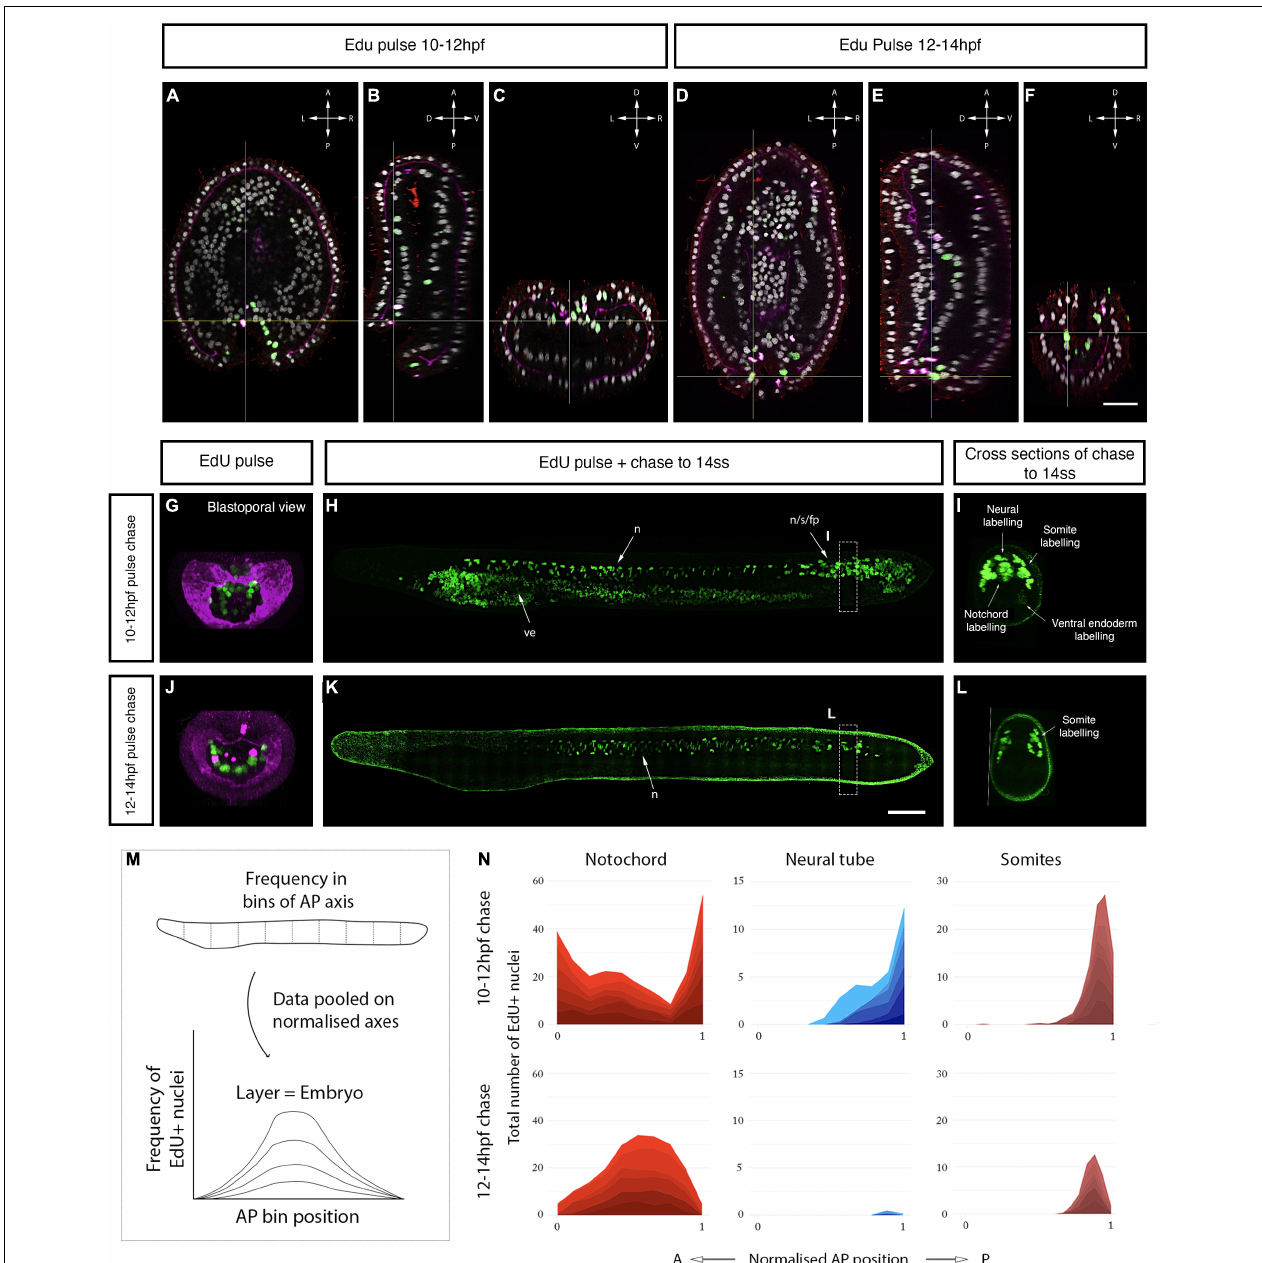
FIGURE 6 | Axial progenitor fates are spatially regionalised across the late blastopore lip. (A–C) Distribution of EdU- and PhH3-positive nuclei after an EdU pulse between 10 and 12 hpf, shown in orthogonal coronal (A) , sagittal (B) , and transverse sections (C) intersecting at the level of the blastopore (as indicated by the yellow lines). Scale bars are 30 µ m. (D–F) Distribution of EdU-positive nuclei after an EdU pulse between 12 and 14 hpf, shown in a coronal (D) , sagittal (E) , and transverse sections (F) intersecting at the level of the blastopore (as indicated by the yellow lines). Compass shows orientation of each plane in panels (A–F) . (G) Maximum projection through the blastopore in an embryo pulsed with EdU between 10 and 12 hpf, as shown in panel (C) , marking proliferative cells in the dorsal and upper-lateral lips. (H) Maximum projection through the sagittal midline of an embryo EdU pulsed at 10–12 hpf, as shown in panel (G) , showing contribution of EdU-positive cells in the dorsal blastopore lip to neural tube, notochord and somites. (I) Transverse section through posterior body of embryo shown in panel (H) , showing tissue-specificity of EdU-positive cells. (J) Maximum projection through the blastopore in an embryo pulsed with EdU 12–14 hpf, as shown in panel (F) , showing proliferating cells in the ventral and lower-lateral lips. (K) Maximum projection through the sagittal midline of an embryo EdU pulsed at 12–14 hpf, as shown in panel (J) , revealing the contribution of proliferating cells to the posterior somites. (L) Transverse section through posterior body of embryo shown in panel (K) , showing tissue-specificity of EdU-positive cells. Scalebars are 50 µ m. (M) Schematic of approach used to quantify EdU labelling in pulse-chased specimens as a frequency curve across normalised AP length, following quantification in 10 evenly-sized bins. (N) Stacked area graphs for each pulse-chase condition and tissue. n = 6 embryos per condition. EdU in green, PhH3 (nuclear) and laminin in magenta, acetylated tubulin in red. fp, floor plate; s, somites; n, notochord; ve, ventral endoderm.